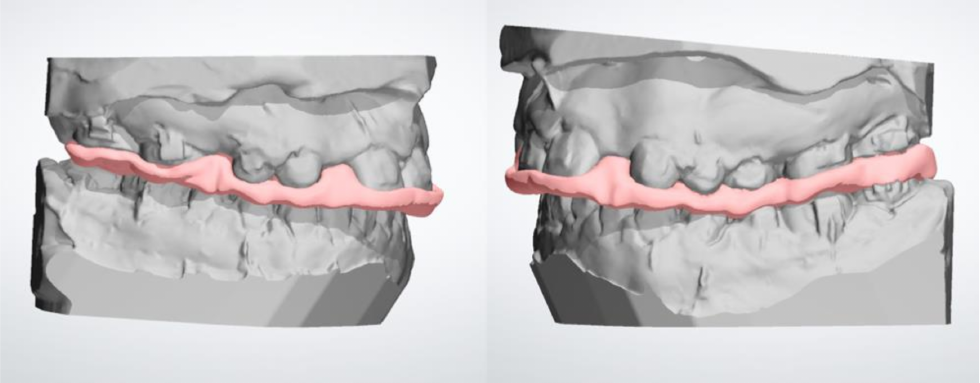
Figure 2. Digital design (CAD) of surgical splint: registration of the digital splint according to the new maxilla–mandibular relationship (surgery